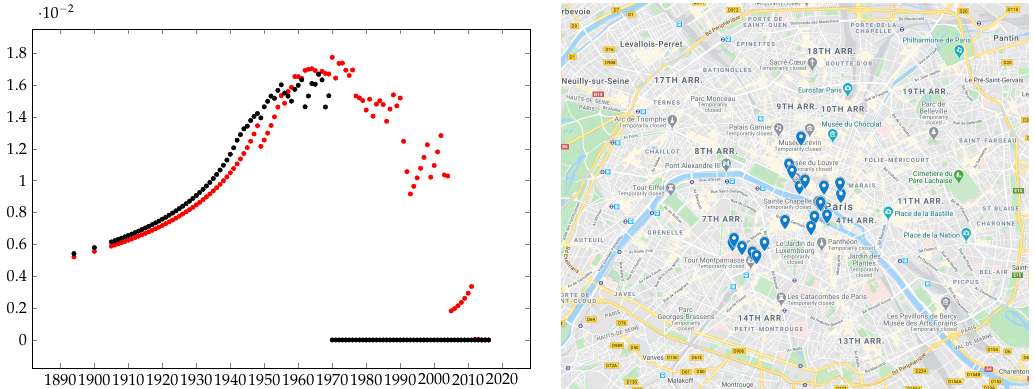
Figure 2. The evolution of the t -closeness of Christopher Lee, in red, and Eleanor Parker, in black, ( left ) and the top-20 nodes in Paris according to the temporal closeness ( right